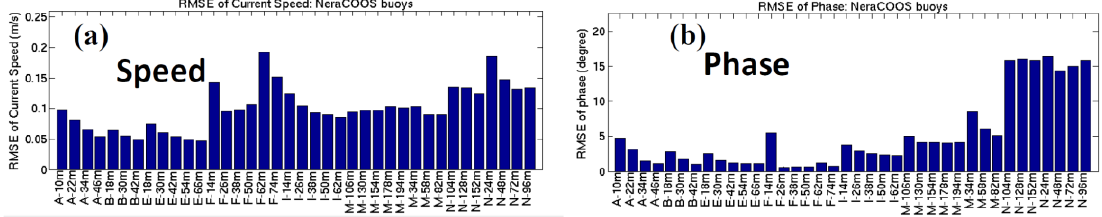
Figure 10. Skill assessment results of the currents speed and phase. ( a ) RMSE of speed and ( b ) RMSE of phase.